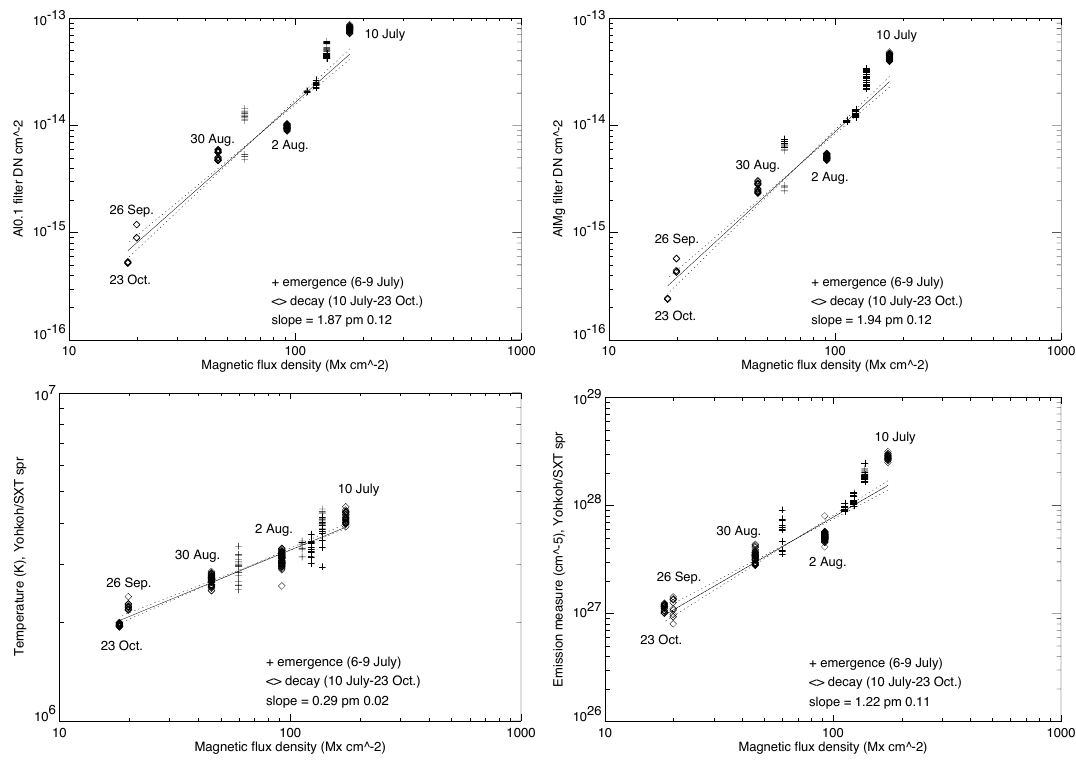
Figure 28: Log-log curve of the flux per unit surface area observed with the Al0.1 and AlMgMn filters temperature and emission measure derived from Yohkoh /SXT versus magnetic flux density ( ¯ 𝐵 ). The solid line shows the linear least-squares fit and the two dotted lines correspond to the 3 𝜎 error in the slope of the solid curve. Only the decaying phase (points mark with ◇ ) are included in the least-squares fit. The same analysis has been done for Yohkoh /BCS data. Image reproduced with permission from van Driel-Gesztelyi et al. (2003b), copyright by AAS; see also van Driel-Gesztelyi et al.